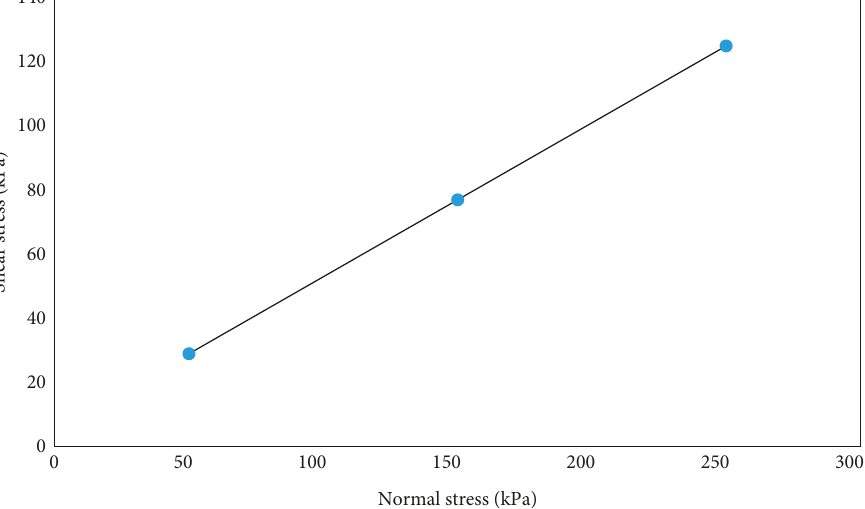
Figure 4: The result of the direct shear test of soil.